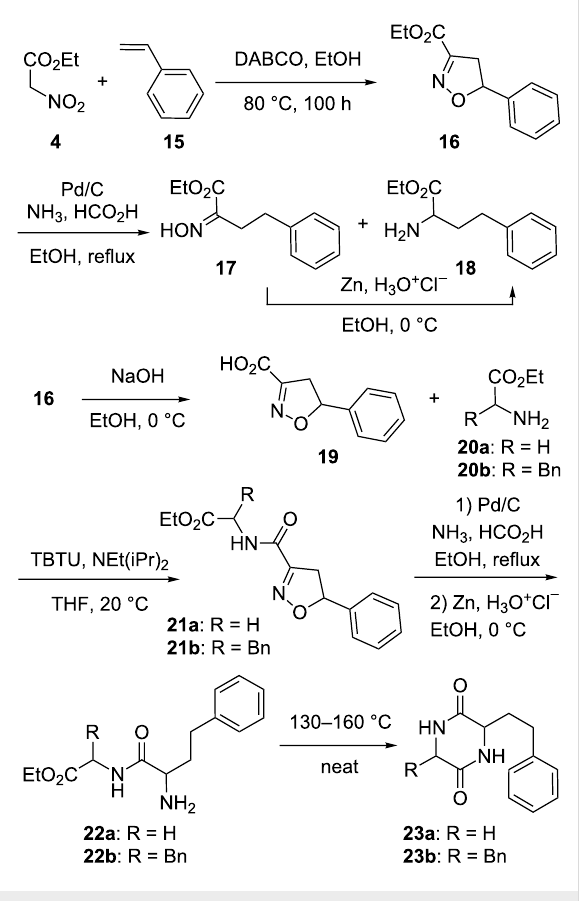
Scheme 3: Syntheses of α -amino ester 18 and piperazinediones 23a , b